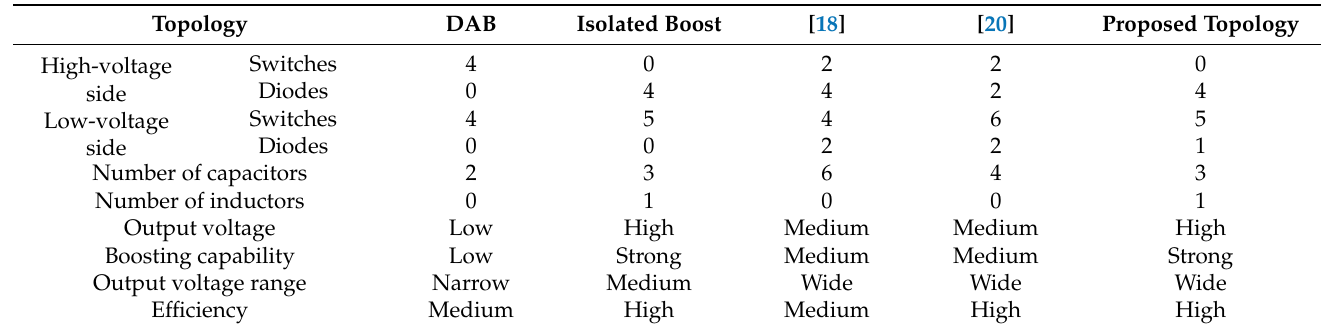
Figure 5. The relationship between voltage gain and duty cycle. Table 2. Comparison between different isolated